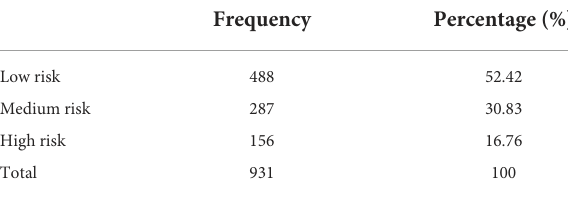
TABLE 1 Basic information on the risk of falls in the older